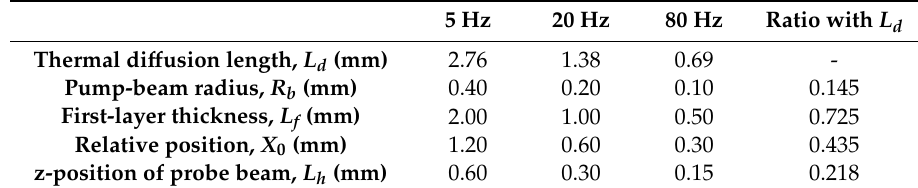
Figure 6. Nondimensionalization of the scanning results using different modulation frequencies. Table 2. System conditions in Figure 6.